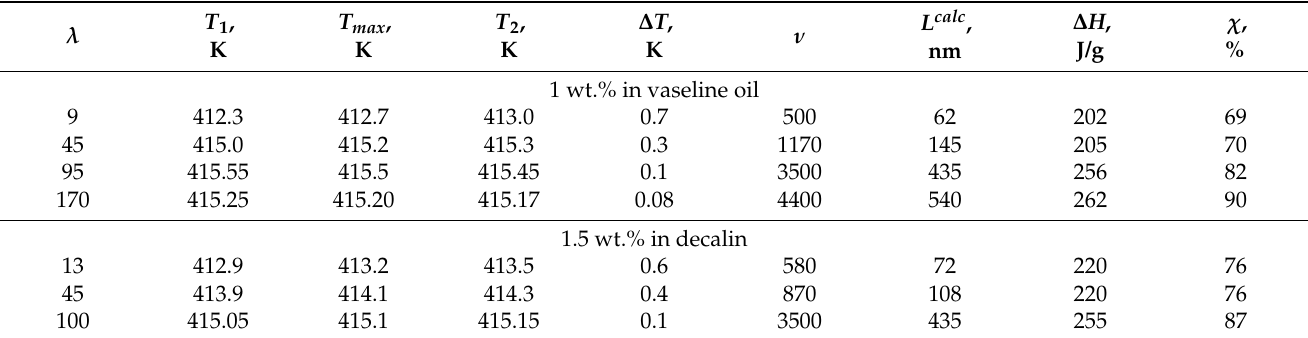
Table 2. Thermodynamic parameters of the melting peak of the samples from xerogels with different drawing ratios λ .